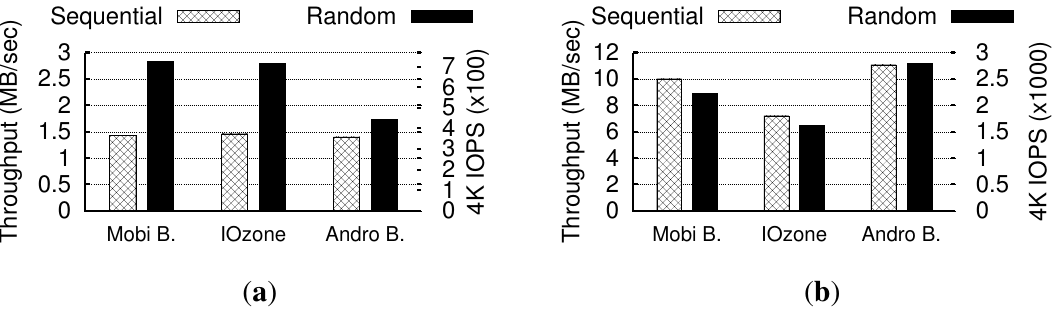
Figure 6. I/O on internal eMMC. ( a ) Synchronous write; ( b ) Direct read. Filesize: 512